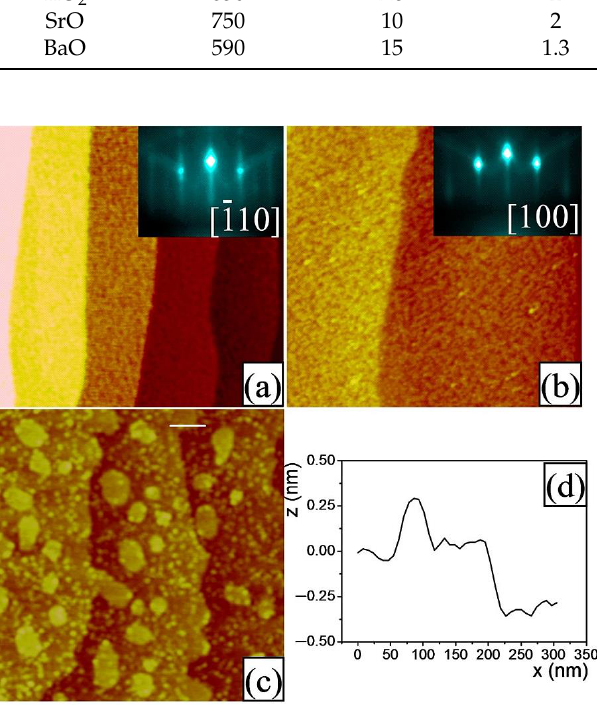
Figure 5. AFM images of (001) NdGaO 3 substrates (cut from the same larger wafer) characterized by an angle  of 45°: ( a ) chemically etched for 2 min in m-BHF solution and annealed for 2 h at 1000